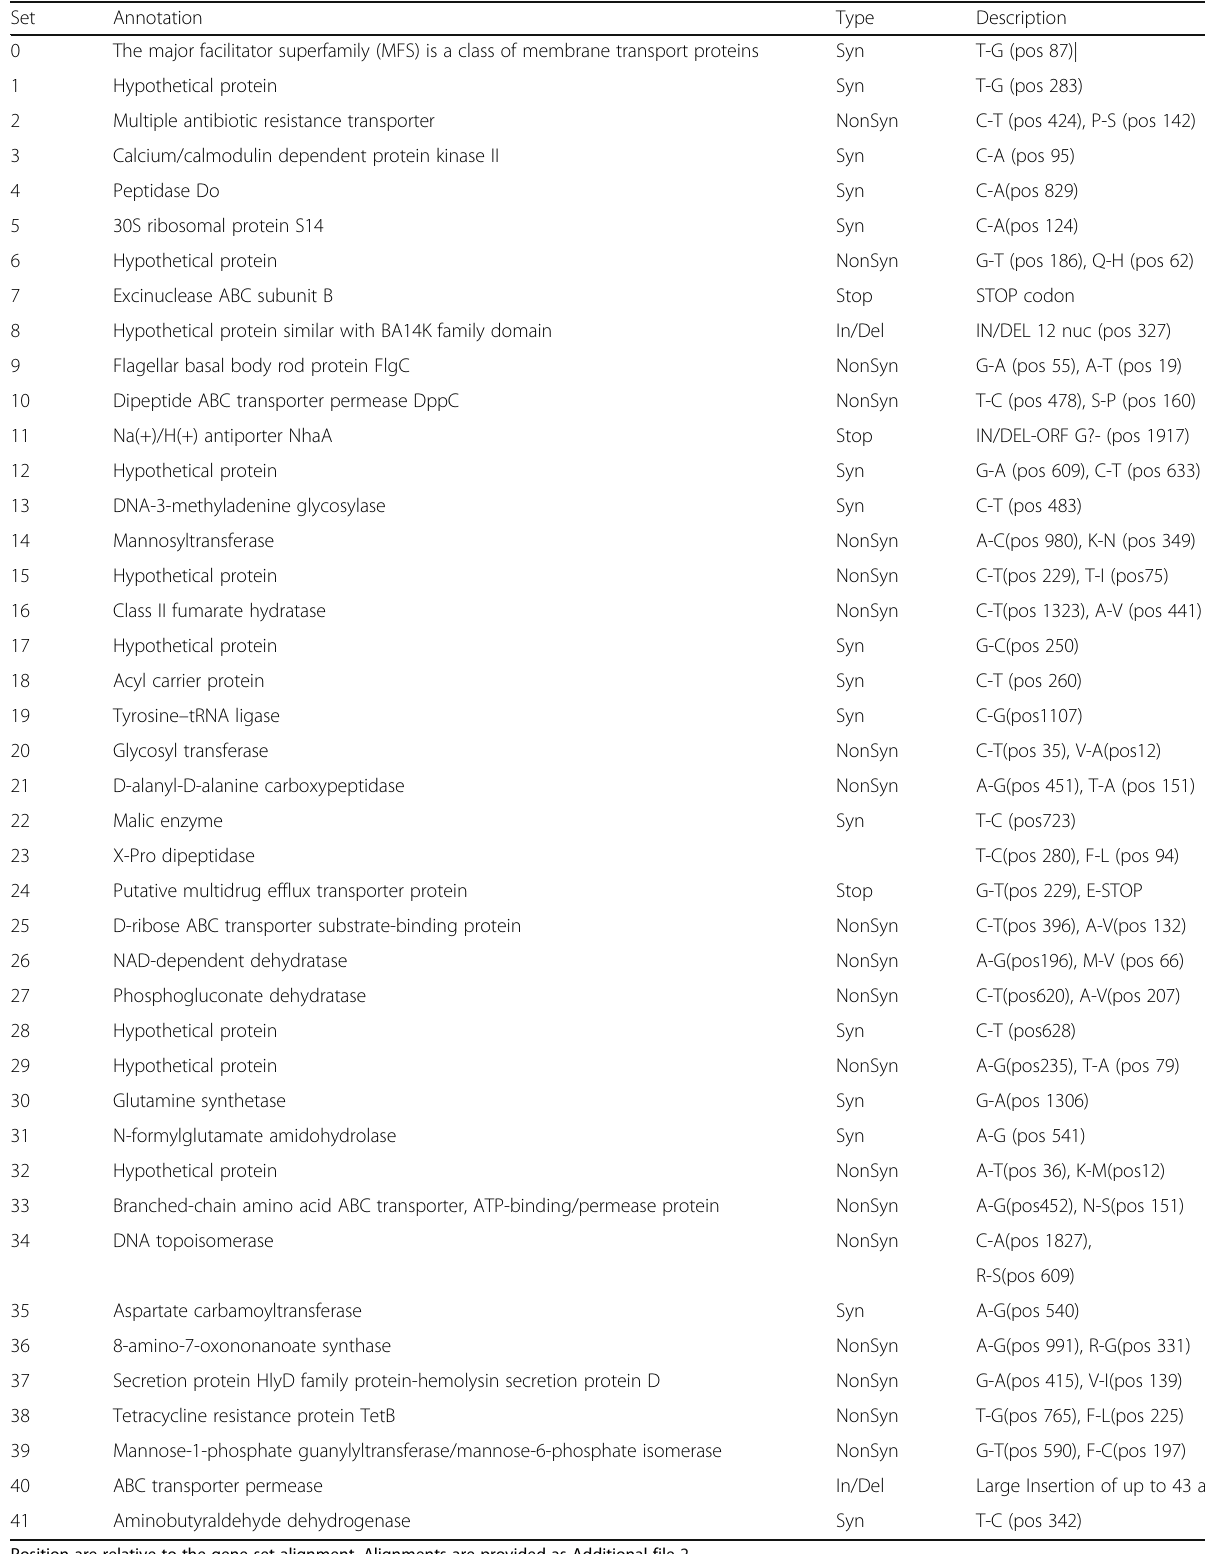
Table 6 Analysis of polymorphic genes that differentiate biovar 4 from other